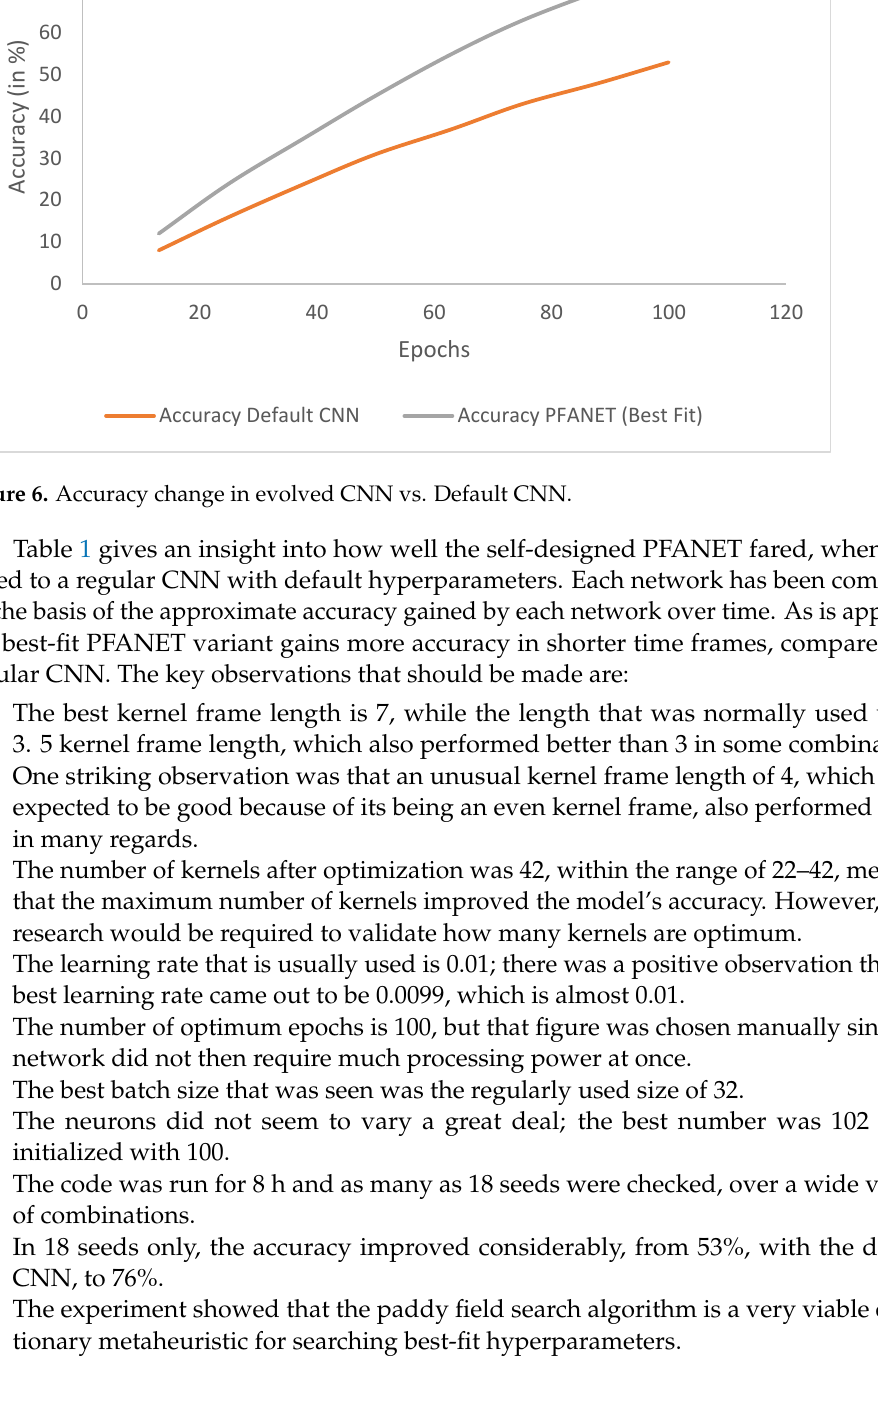
Figure 5. Accuracies for the evolved seeds in the network.